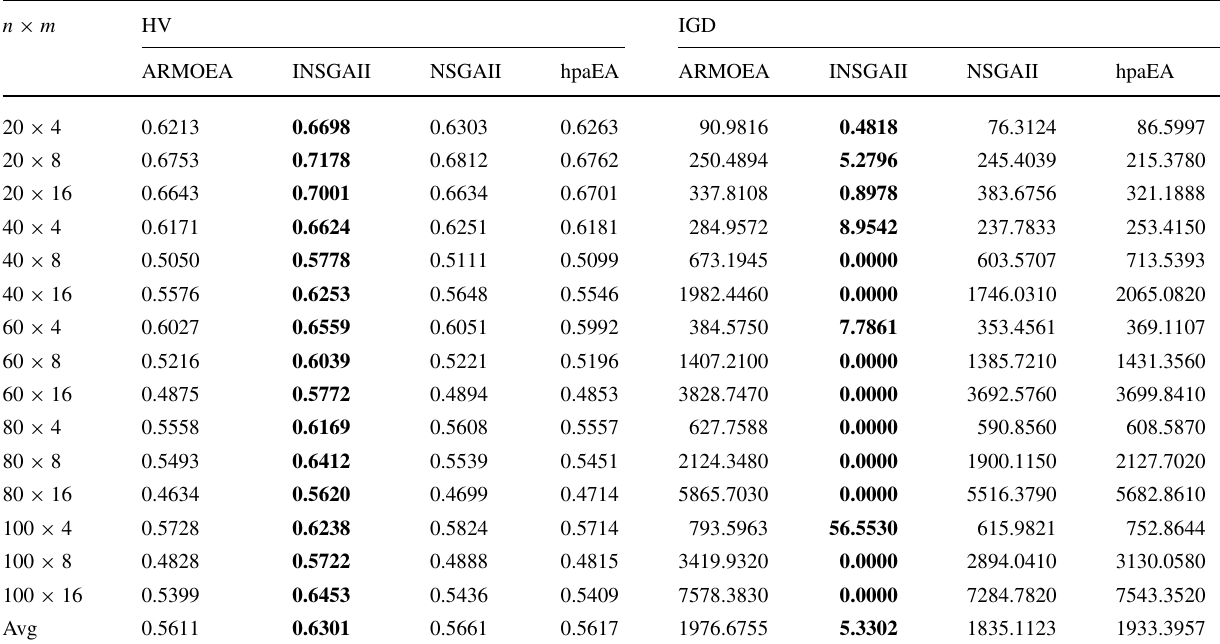
Table 12 Results of the algorithms ( g (cid:2) 4)